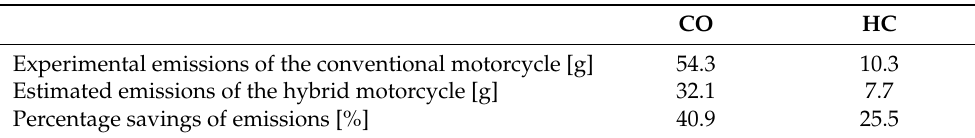
Figure 9. Battery characteristics: ( a ) Battery State of Charge; ( b ) Discharge current; ( c ) Battery voltage and current. Table 4. Savings of emissions utilizing a hybrid motorcycle instead of a conventional motorcycle on the distance travelled of 44.8